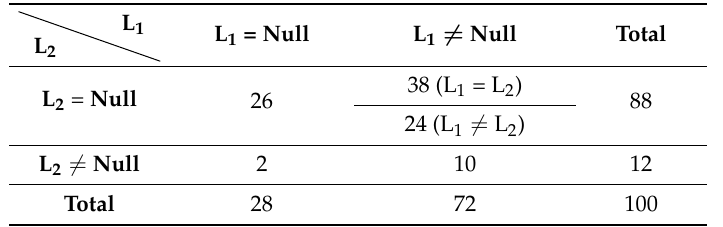
Table 4. Location information statistics of the geographical locations of the 100 webcasters.